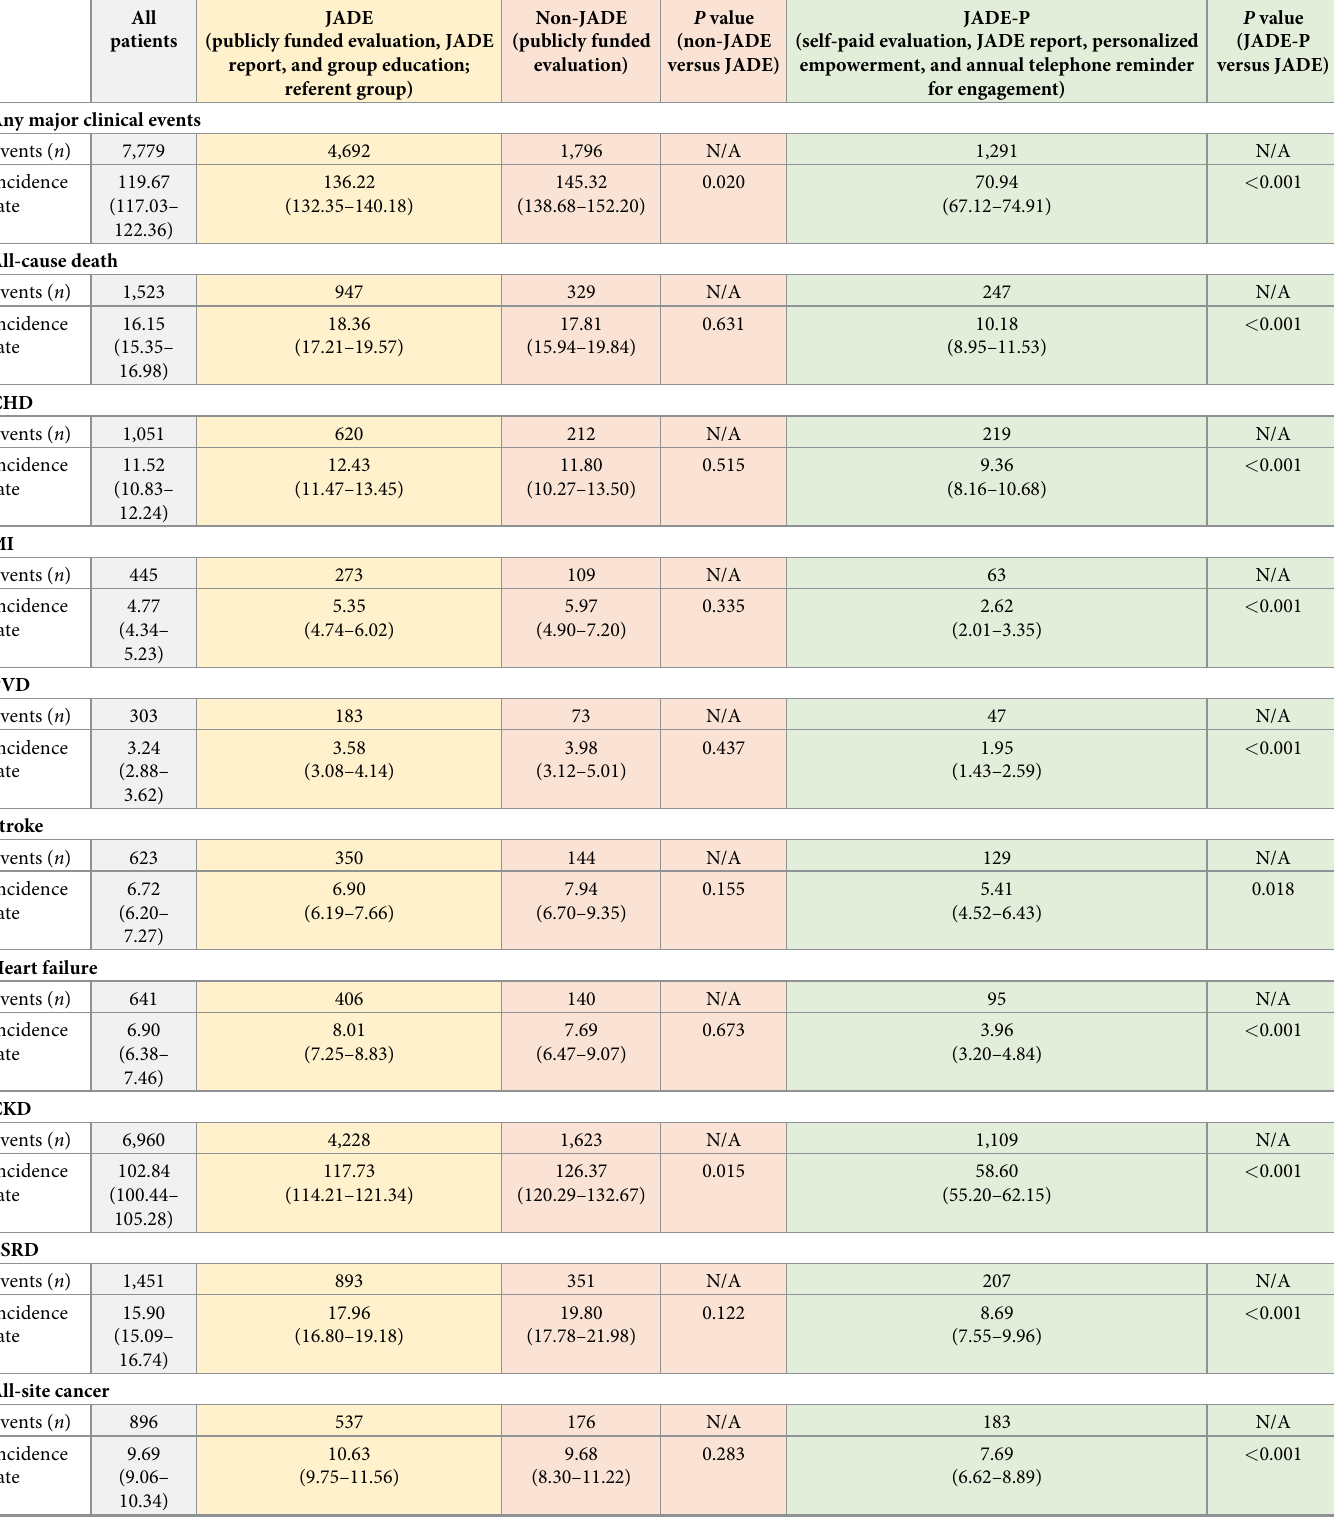
Table 2. Incidence rates of clinical events and hospitalization (cases per 1,000 patient-years) in all patients with type 2 diabetes managed in 3 care settings, namely non-JADE, JADE-P, and JADE (referent). All